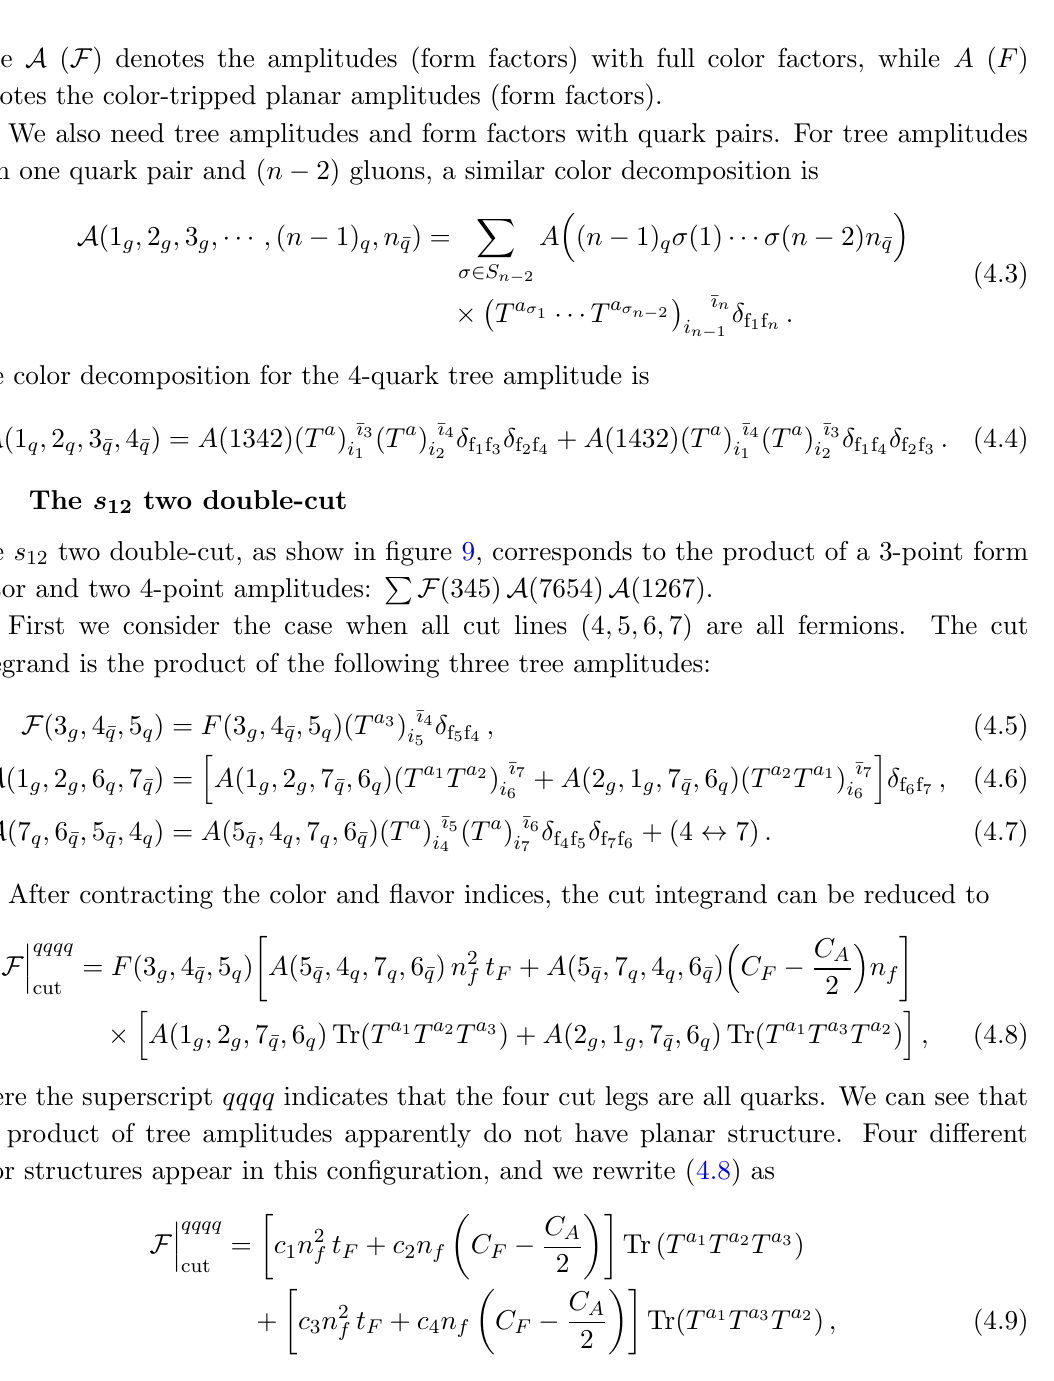
Figure 9 . The s 12 two